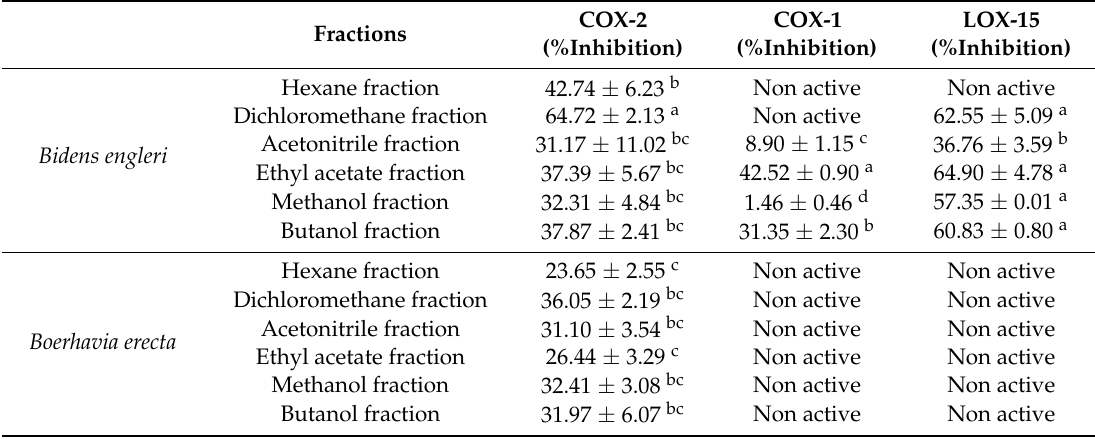
Table 2. Anti-inflammatory activities of